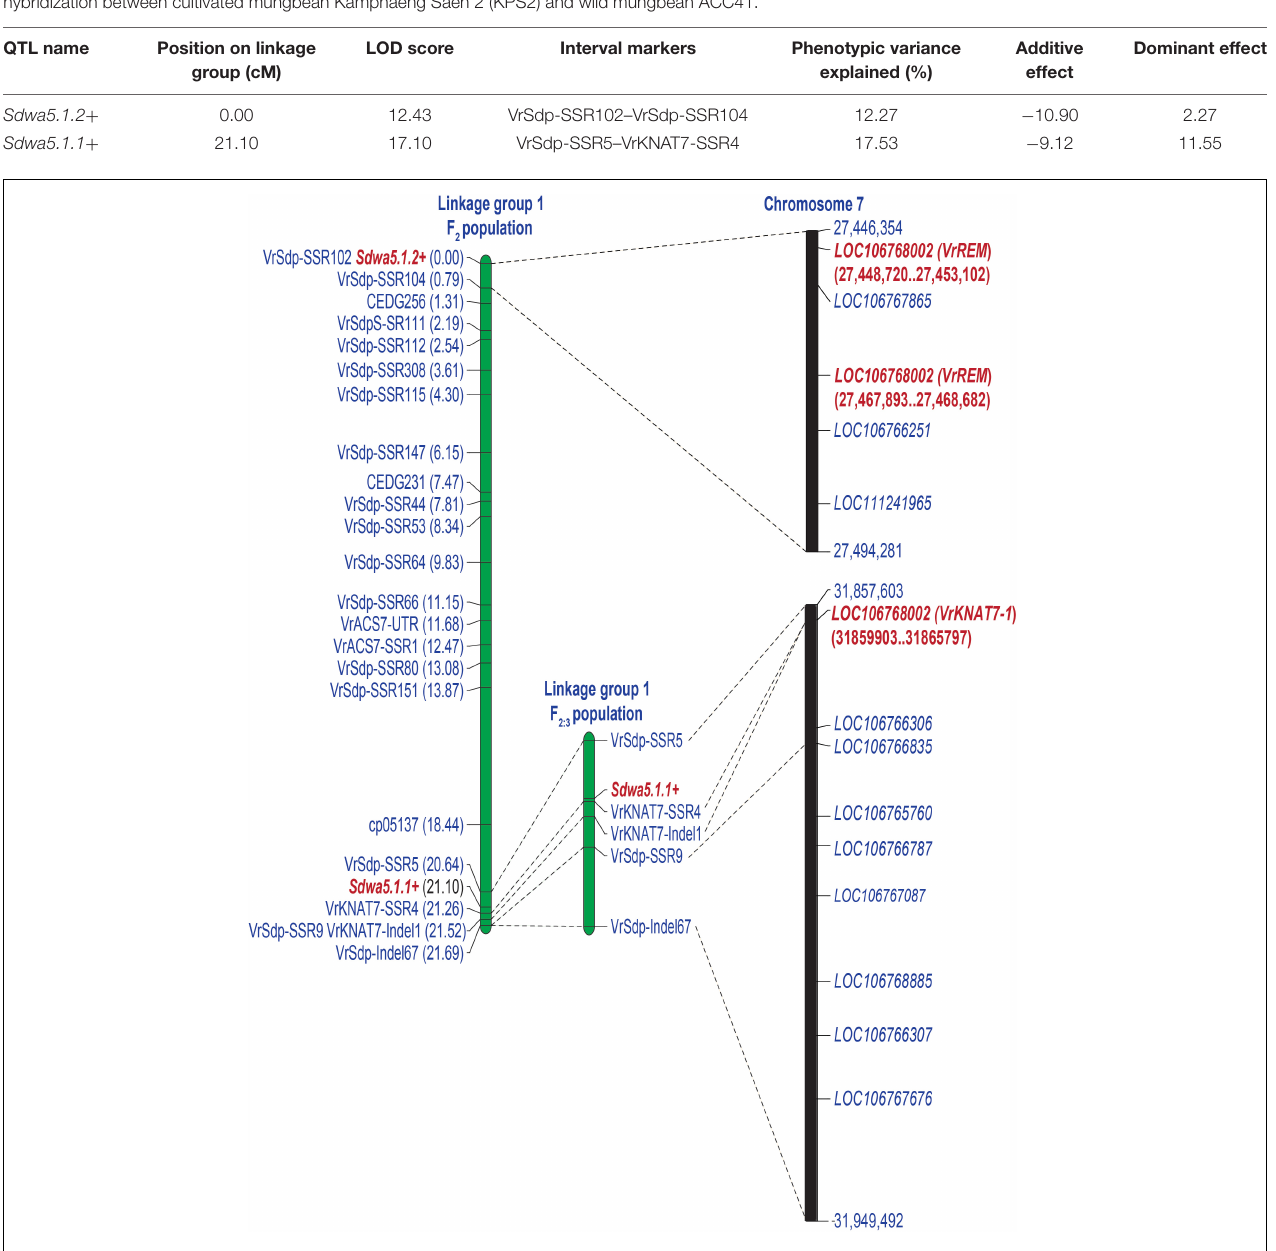
FIGURE 5 | A comparative map illustrating the position of the QTLs Sda5.1.1 + and Sdwa5.1.2 + controlling seed dormancy on the reference genome of mungbean (VC1973A). Candidate genes at the Sdwa5.1.1 + and Sdwa5.1.2 + are highlighted in red and bold.